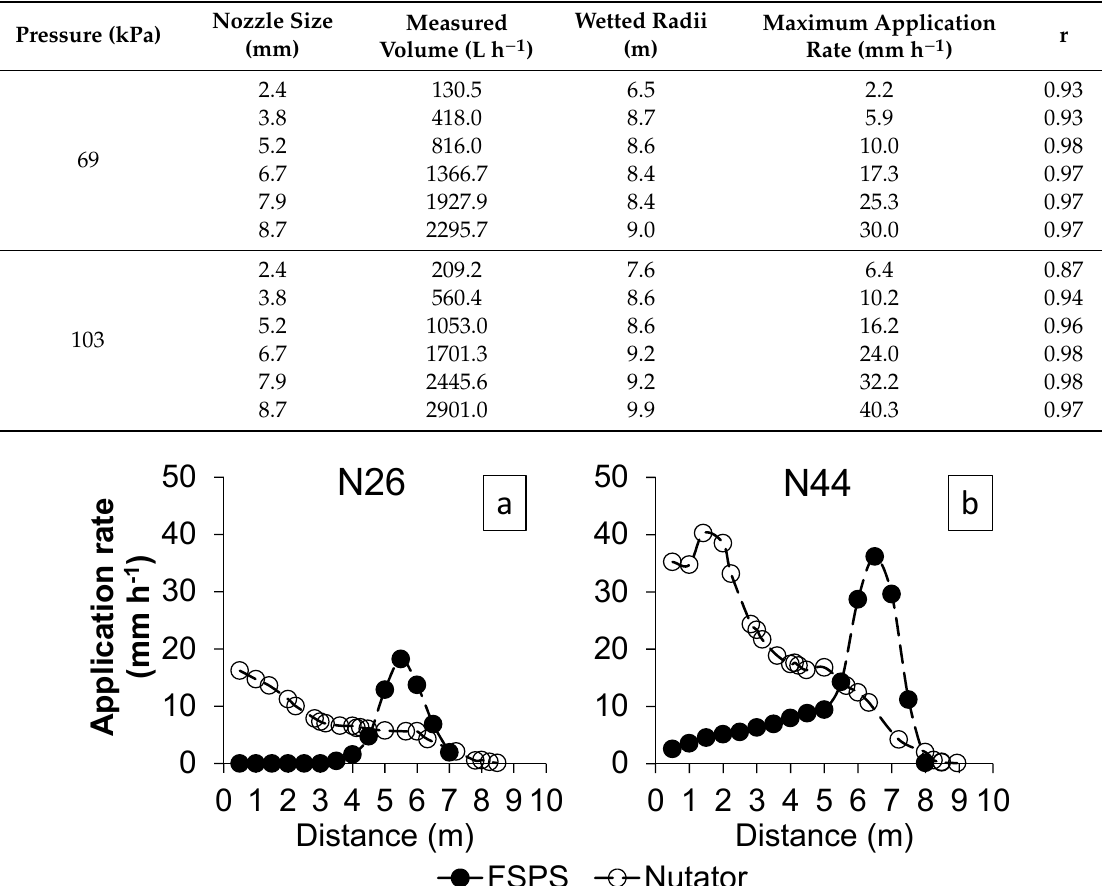
Figure 4. Measured radial water application at 103 kPa for ( a ) the nozzle N26 (5.2 mm) and ( b ) nozzle N44 (8.7 mm) of the Nutator sprinkler and FSPS (from Ouazaa et al. [13]).